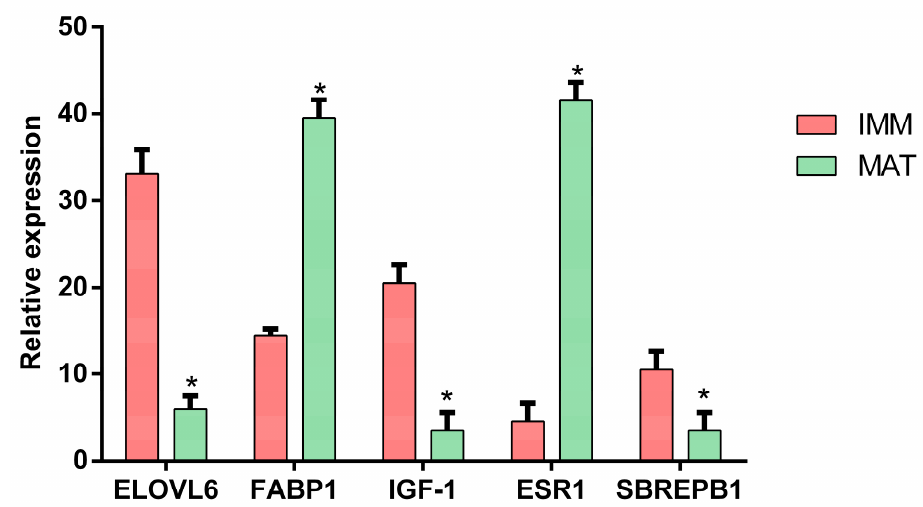
Figure 2. qPCR validation. Bar plot shows gene expression levels of five genes, measured by qPCR between livers of immature ( n = 3) and mature ( n = 3) females. Significance between mature and immature for each gene is shown by an asterisk, and standard error is reported with error bars.